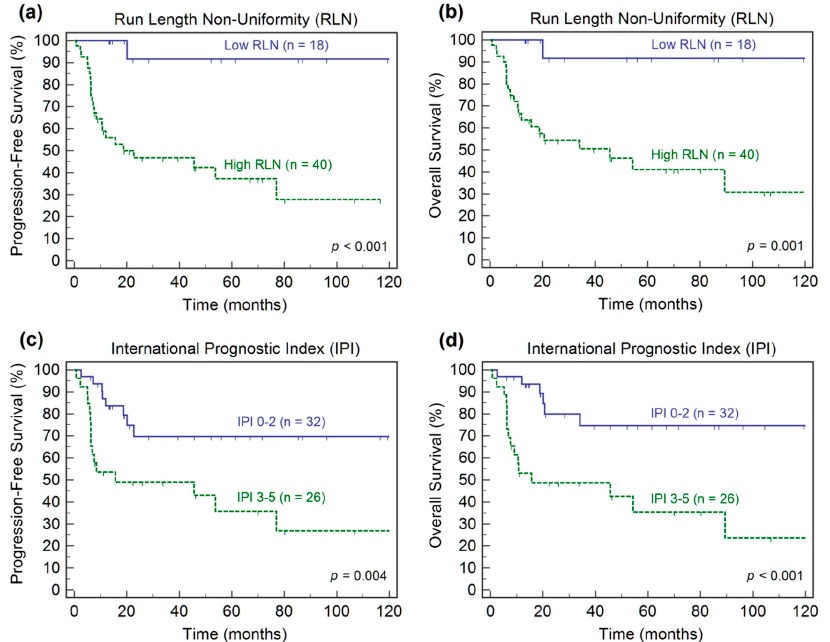
Figure 1. Kaplan–Meier estimates of progression-free survival and overall survival according to the baseline run length non-uniformity ( a , b ) and International Prognostic Index scores ( c , d ).